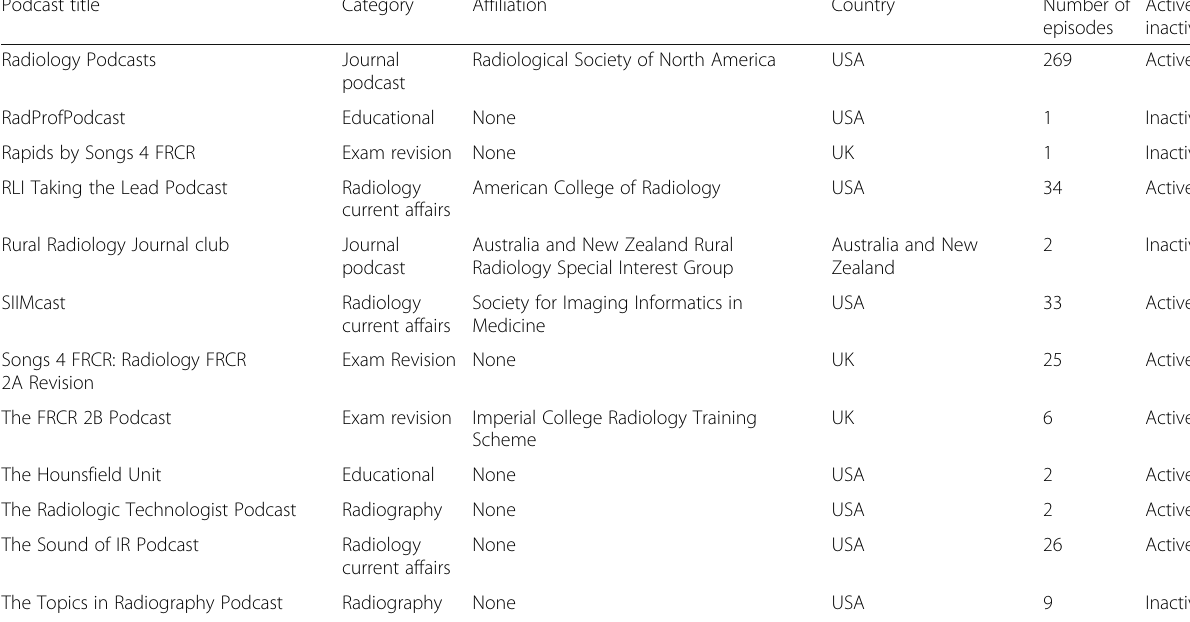
Table 3 Summary of radiology podcast series (data sampled 12 October 2019) (Continued)